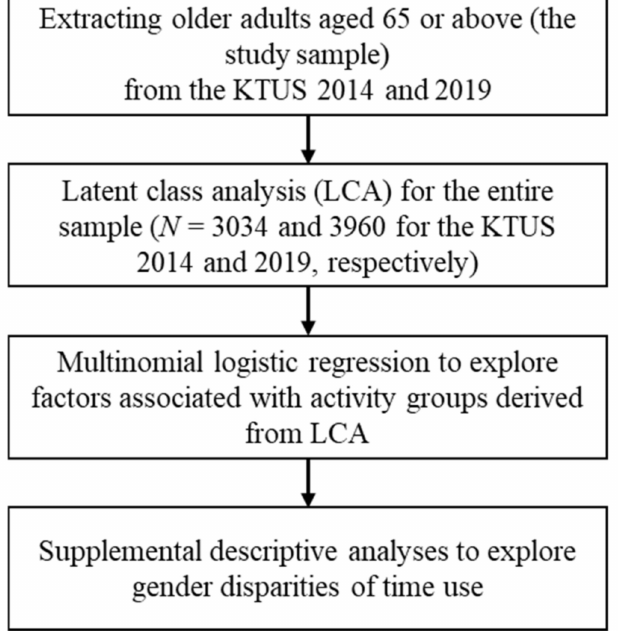
Figure 1. Analytic procedures.